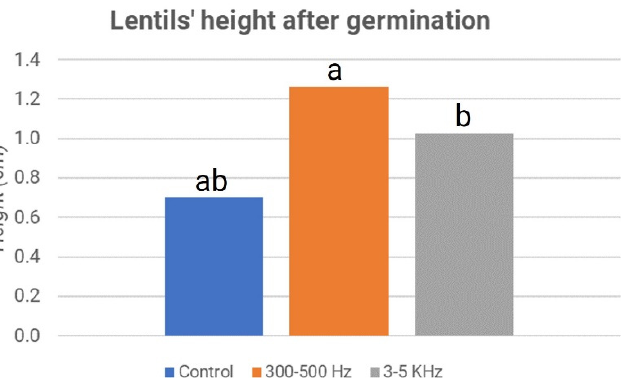
Figure 9. Lentils’ height after germination: second experiment. The letters “a” and “b” refer to the statistical significance of the observed difference between sample couples with a p -value < 0.05 and n = 196.